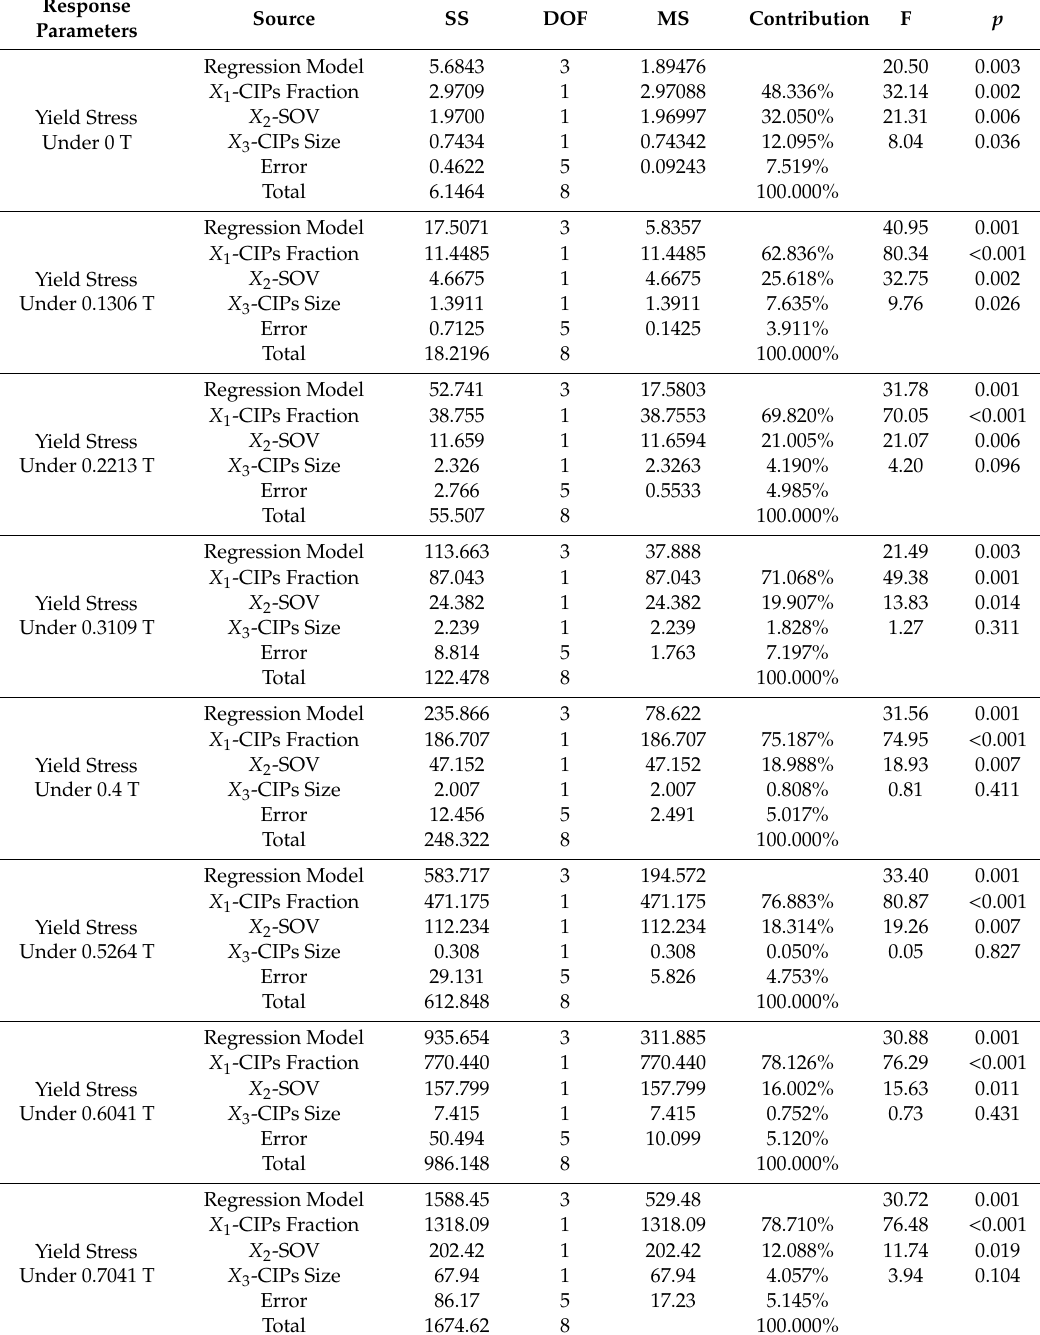
Table 4. Analysis of variance (ANOVA) for response